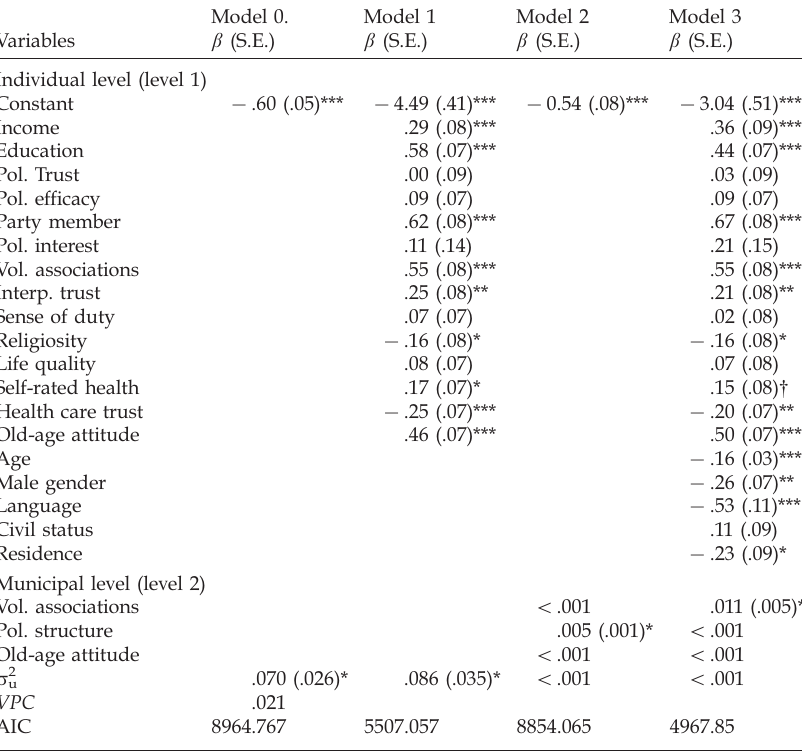
Table 6. The effect of indi v idual- and municipal-le v el v ariables on protesting Model 0. Model 1 Model 2 Model 3 Variables b (S.E.) b (S.E.) b (S.E.) b